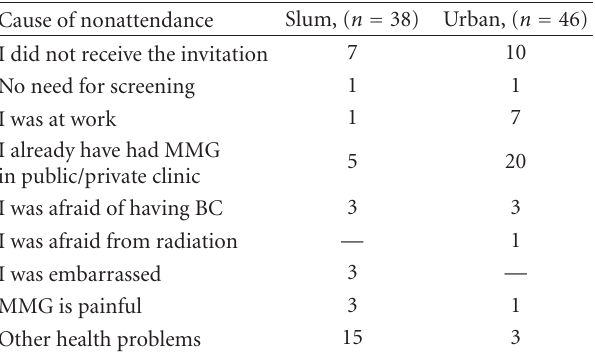
Table 3: Principal reasons stated for nonattendance to mammog- raphy screening